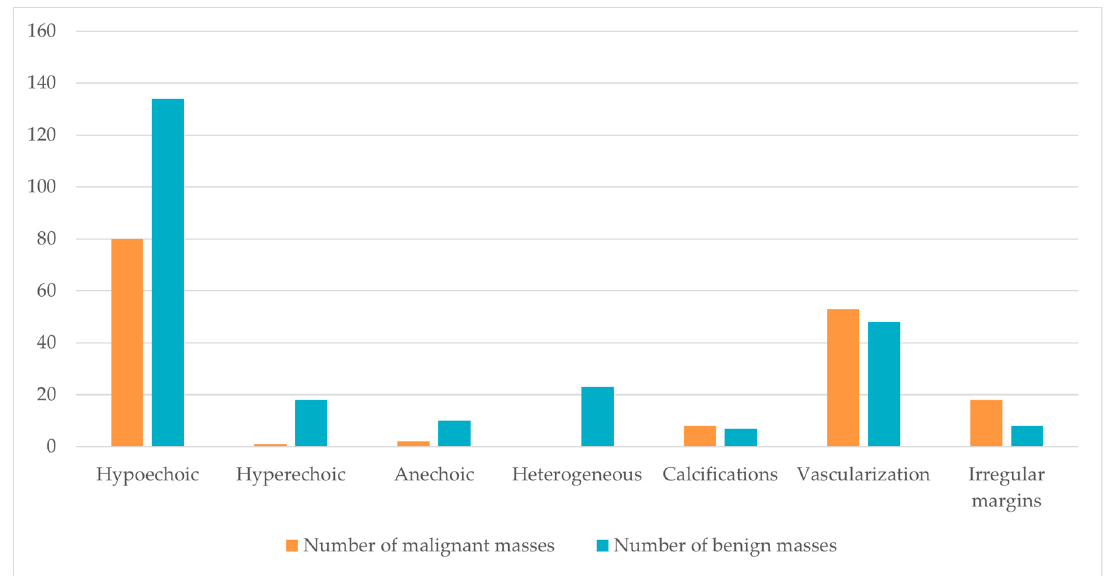
Figure 2. Final histology of small testicular masses according to ultrasonographic characteristics.